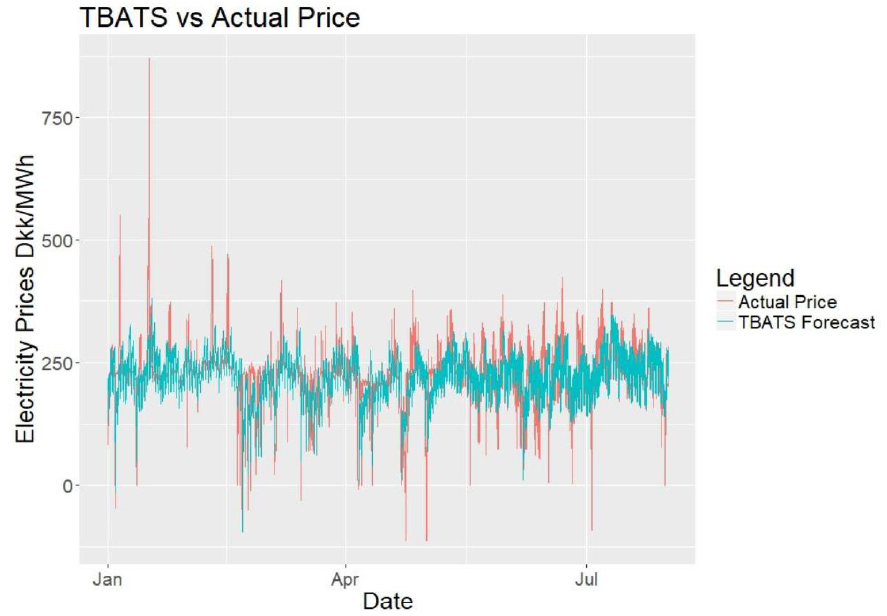
Figure 16. TBATS vs. actual price.